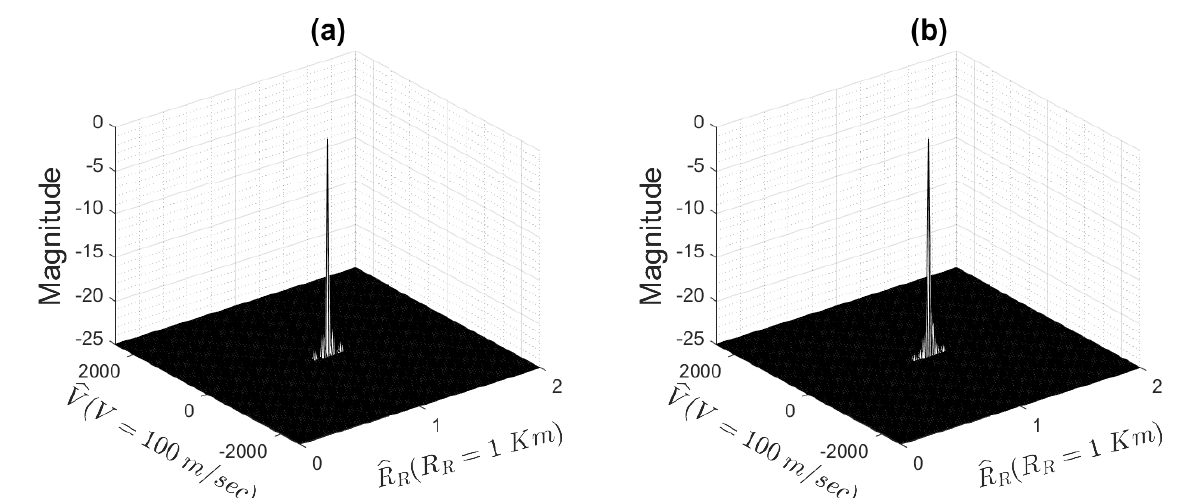
Figure 15. Ambiguity surface of Monostatic radar for ( a ) the Lorenz CBFM waveform and ( b ) the Burke–Shaw CBFM